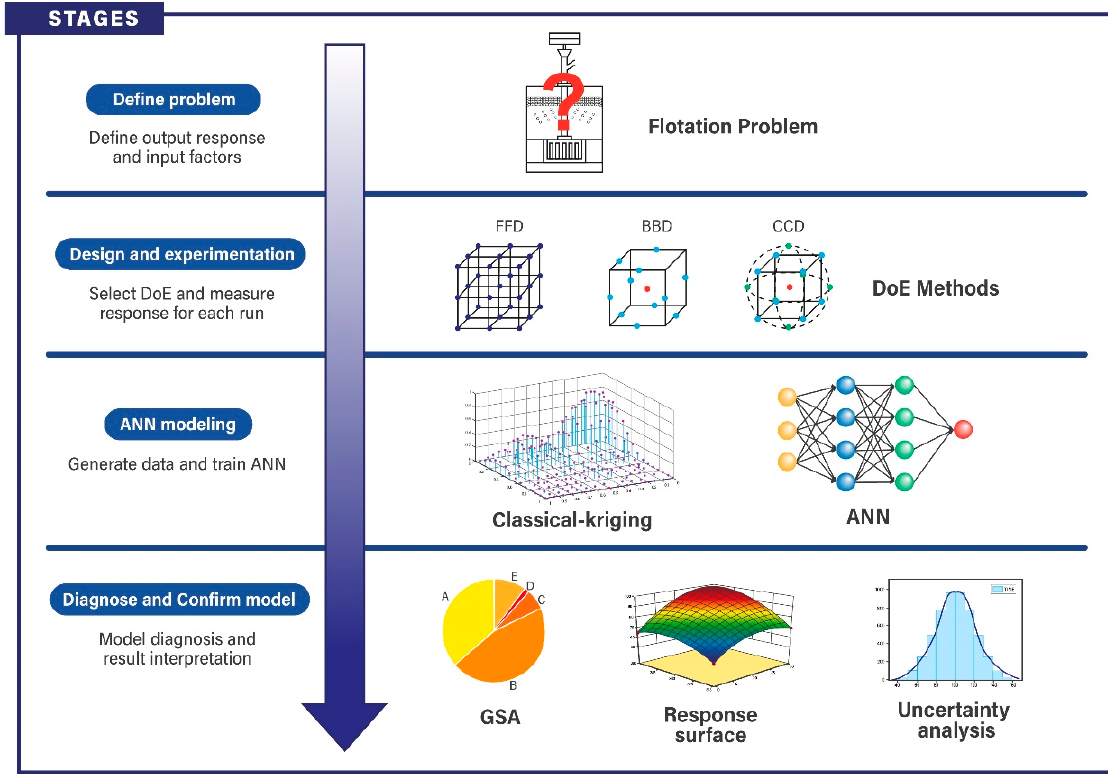
Figure 1. The methodology proposed in this work.